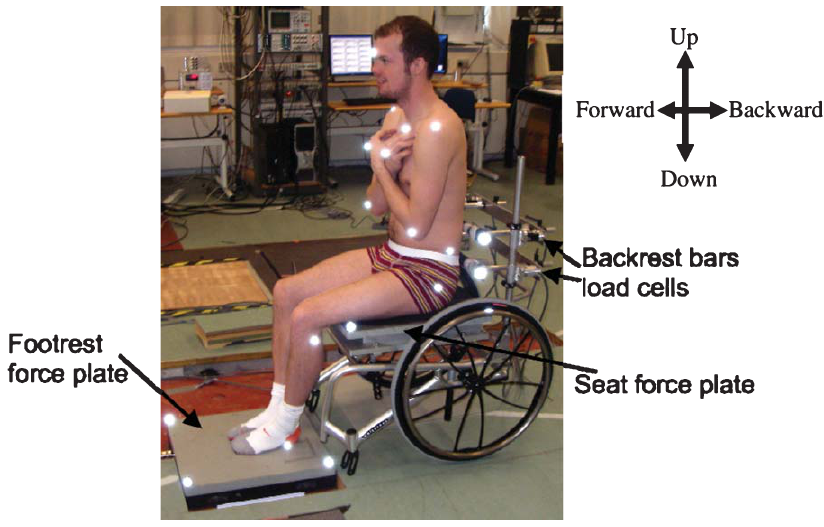
Fig. 2. The experimental setup with a subject sitting on the instrumented chair. The white dots are the reflective markers used for motion